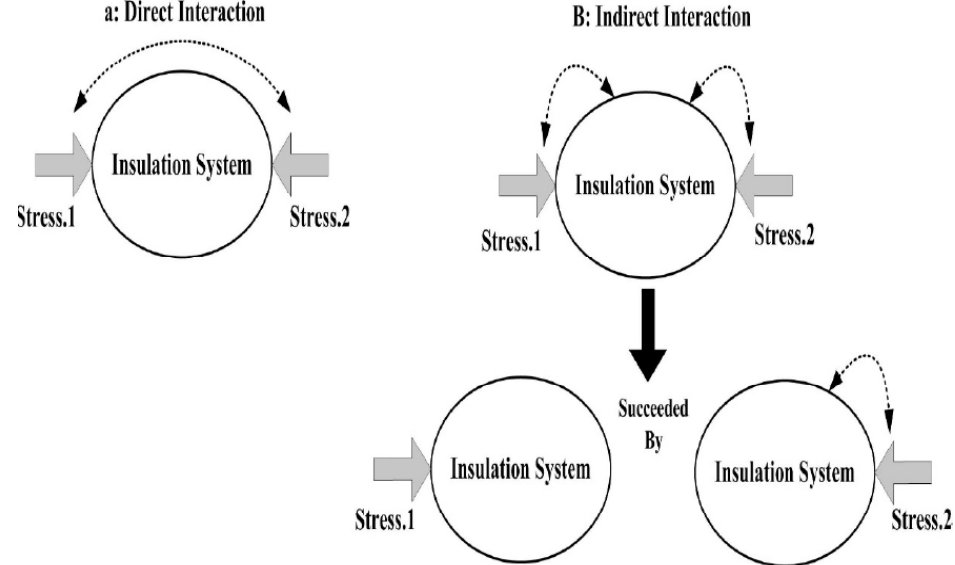
Fig. 17. (a) Direct Interaction, (b) Indirect